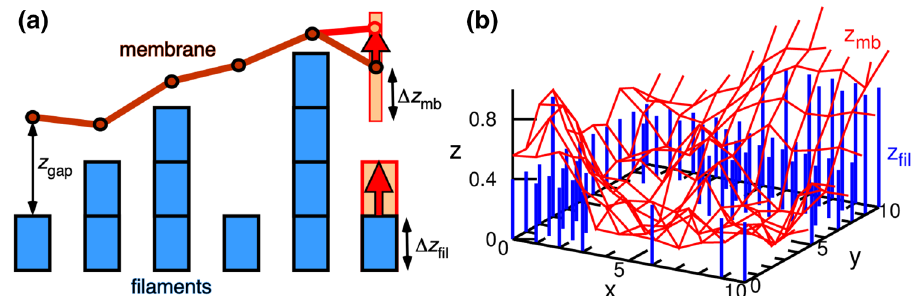
Figure 1. Motion of the membrane and filaments. ( a ) Schematic of the membrane and filaments. According to the Metropolis MC method, the membrane moves with a vertical ( z ) step taken from a uniform random number (cid:31) z mb , (cid:31) z mb in . The filament grows stepwise with a probability p fil . ( b ) Snapshot of a part of the membrane [− ] 4096 in case I (tension constraint). The red mesh and 0.5 , γ 0 , and N 0.4 , p fil and filaments at (cid:31) z fil = = = = blue bars represent the membrane and filaments, respectively. The origin of the z coordinate is taken at the minimum value of the filament position z fil .